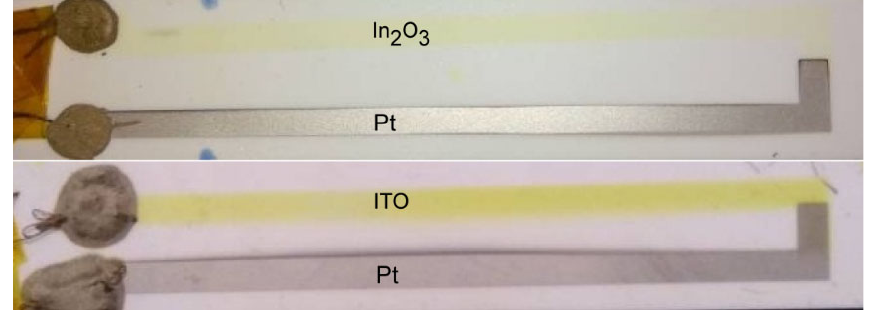
Figure 1. Physical images of ITO/Pt and In 2 O 3 /Pt